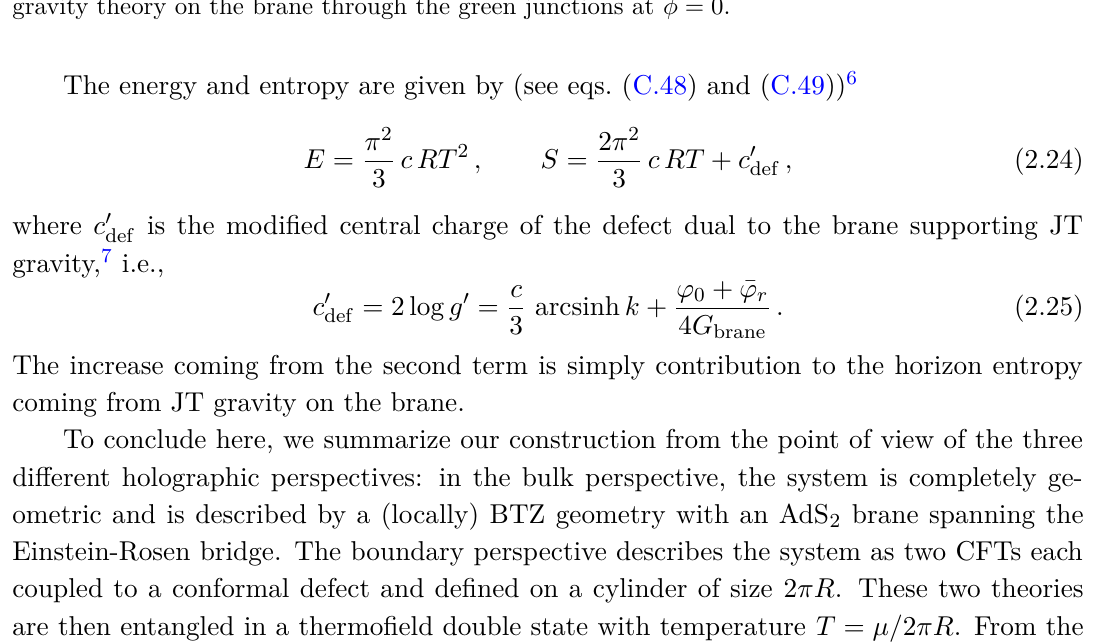
Figure 2 . Penrose diagram of the system from the brane perspective. The brane inherits an eternal black hole geometry (2.15). The two bath CFTs are defined on a cylinder and are coupled to the gravity theory on the brane through the green junctions at φ = 0